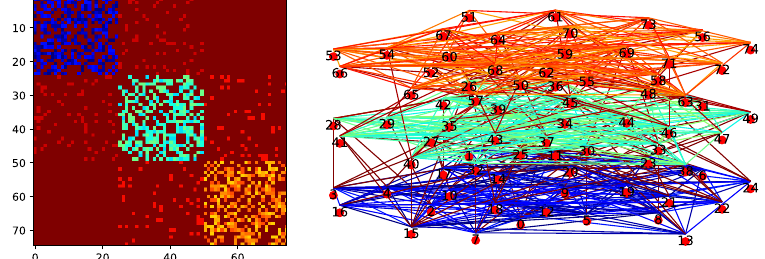
Figure 7. Example of a 75-Node three layer network and its adjacency matrix.